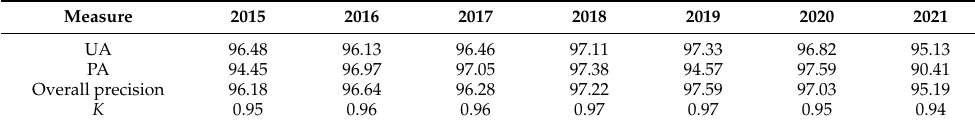
Table 10. Overall precision and Kappa coefficient ( K ) for class-based